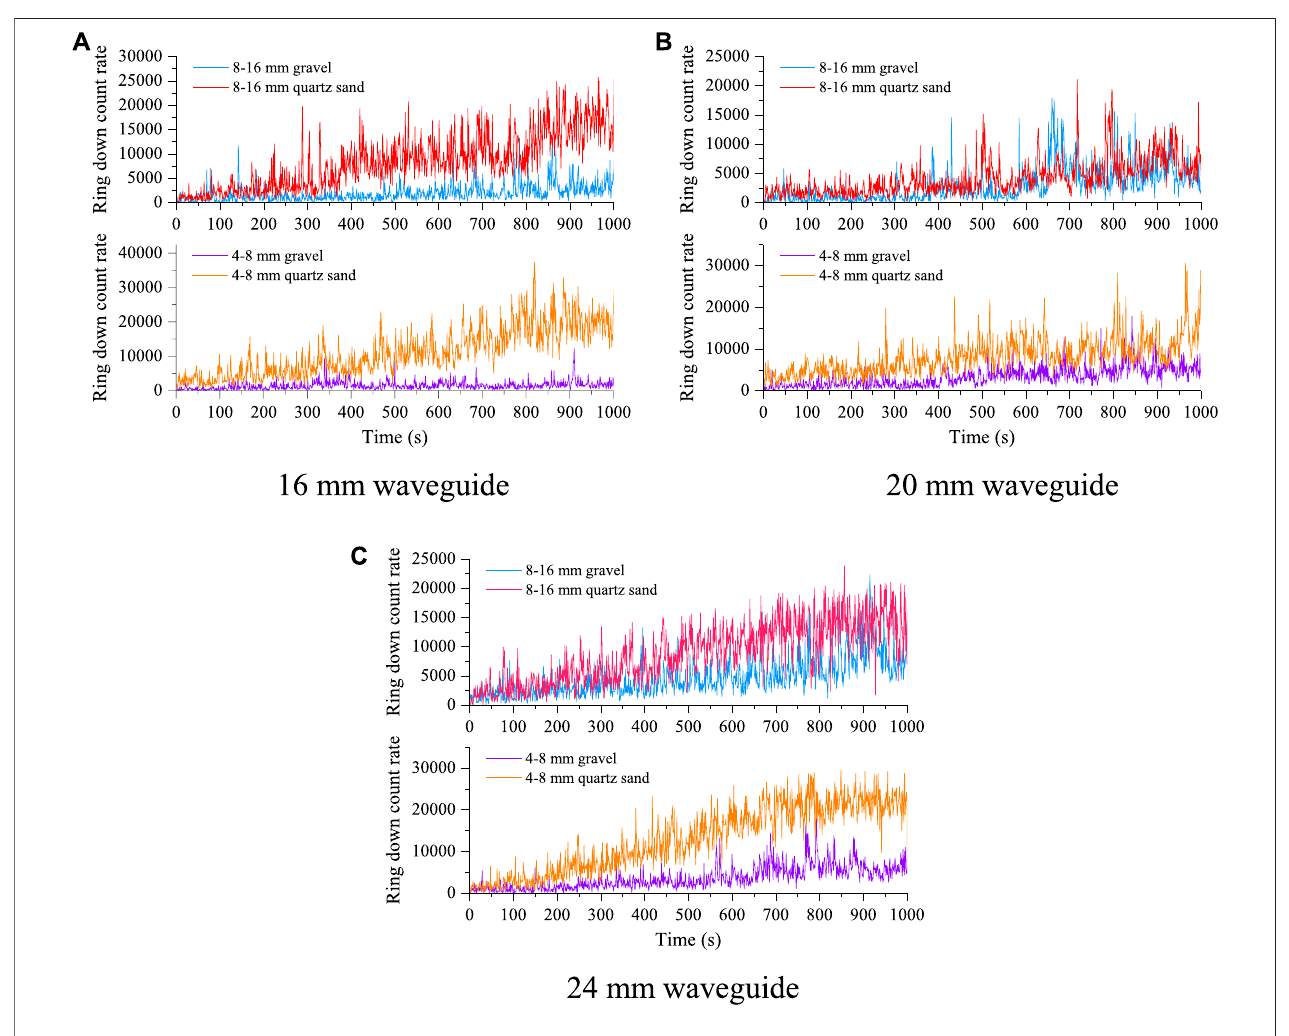
FIGURE 6 | Flexural guided wave ring down count rate versus